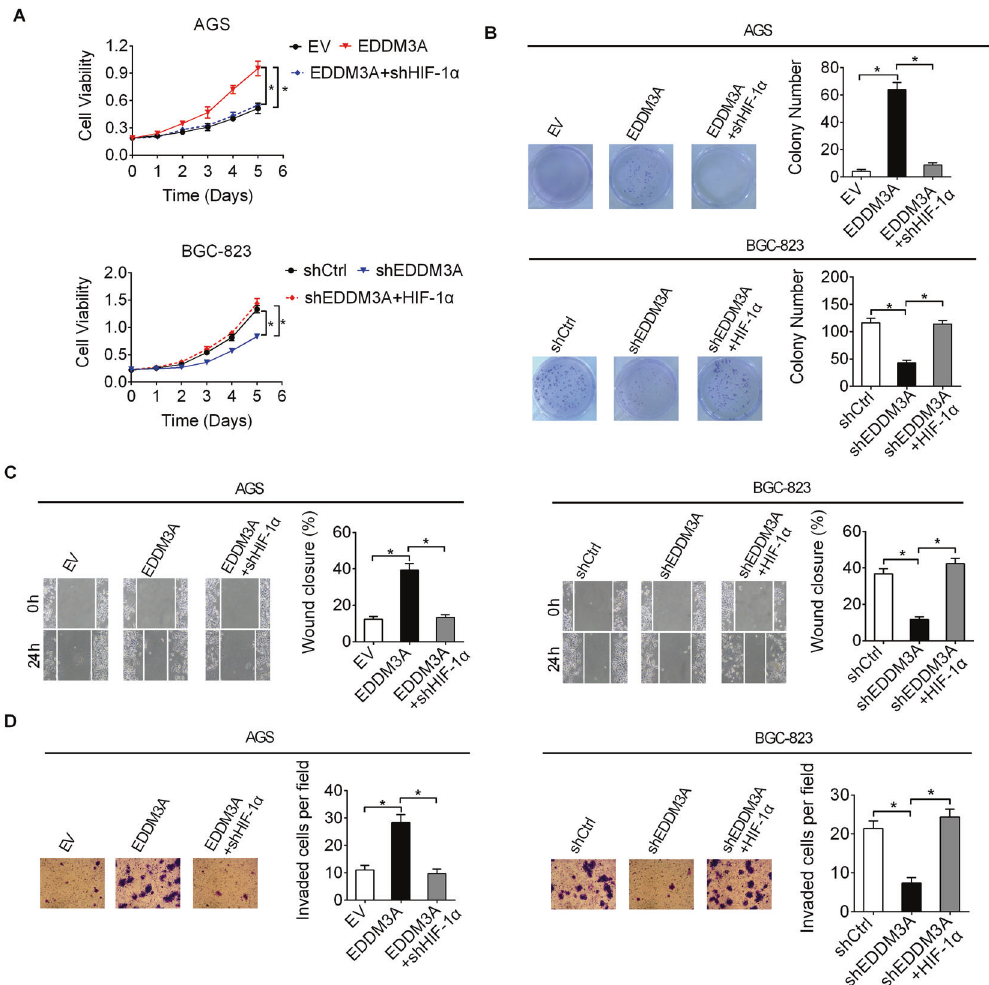
Fig. 8 EDDM3A promoted the growth and metastasis of GC by increasing aerobic glycolysis. A , B In vitro cell proliferation of AGS and BGC- 823 cells with different treatment were determined by MTS cell viability and colony formation assays. C, D In vitro cell metastasis of AGS and BGC-823 cells with different treatment were determined by wound-healing migration and matrigel invasion